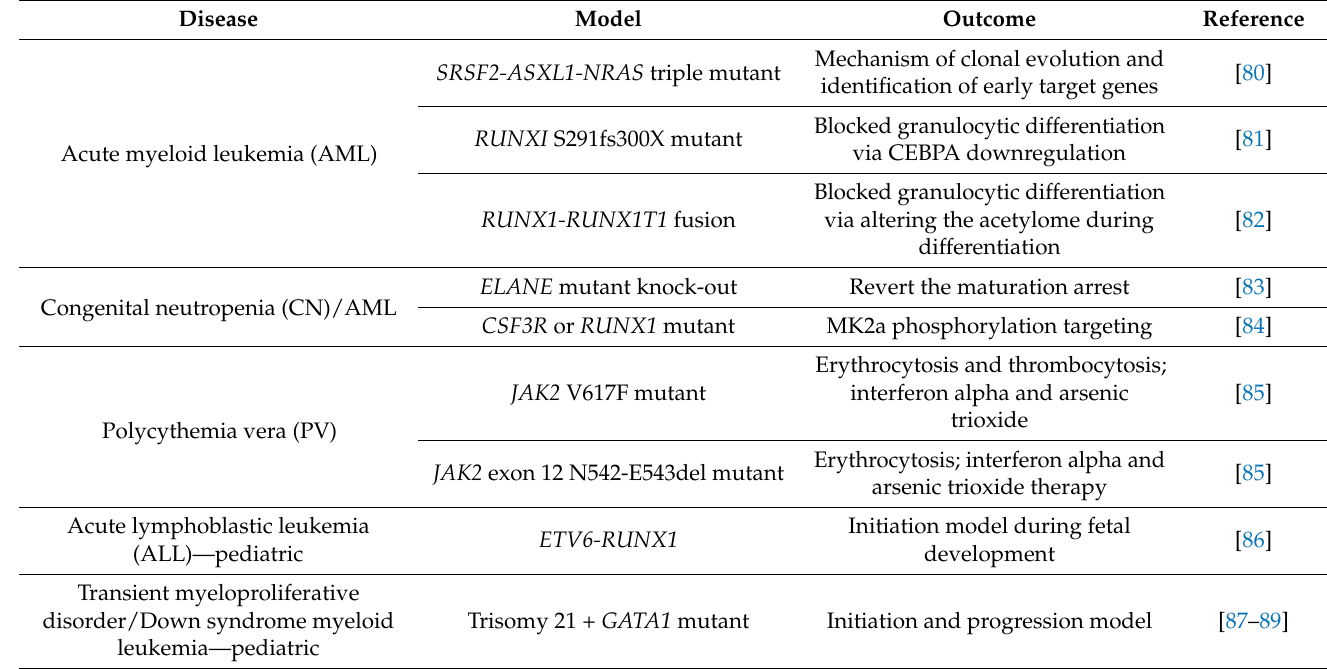
Table 2. Genetically engineered iPSC models for hematological